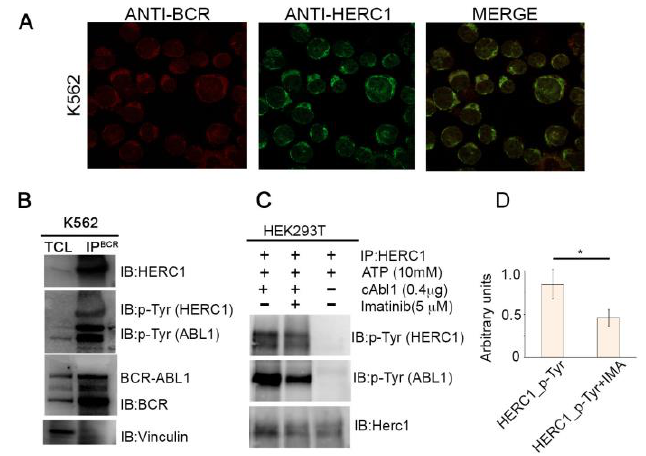
Figure 6. HERC1 is a novel interactor and a potential substrate of Bcr-Abl1. ( A ) The subcellular localization of either the HERC1 or Bcr-Abl1 (p210) proteins were assessed by staining cytospun K562 cells with anti-HERC1 and anti-Bcr specific antibodies. The immunofluorescence assay revealed that the localization of the two proteins was mostly restricted to the cytoplasmic compartment and they co-localized. ( B ) In K562 cells BCR-ABL1 and HERC1 proteins form a complex. The immunoprecipitated BCR-ABL1 was employed to pull-down HERC1 from K562 total cell lysate. The presence of HERC1 in the immunoprecipitated sample was determined by immunoblotting the membrane with HERC1 antibody (upper panel). Subsequently probing with a tyrosine phospho-specific antibody proved the phosphorylated HERC1 status. Vinculin was used as loading control (lower panel). ( C ) In vitro kinase assay with purified c-ABL and HERC1 substrate, obtained after HERC1 immunoprecipitation on 293T, performed in the absence or presence of 5 µM Imatinib treatment for 30 min. ( D ) The effect of the Imatinib showed in ( C ) was measured quantitatively using the ImageJ software. The bands intensity, corresponding to HERC1-P-Tyr protein, were quantified and normalized to the amount of HERC1 protein signal for each lane (the max value was set at 1). Normalized arbitrary units of three different experiments with SD are shown in the bar graphs. * p <